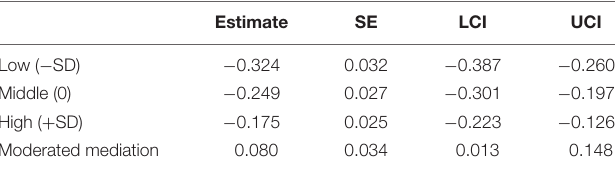
TABLE 4 | Moderated mediating effect of teacher emotional